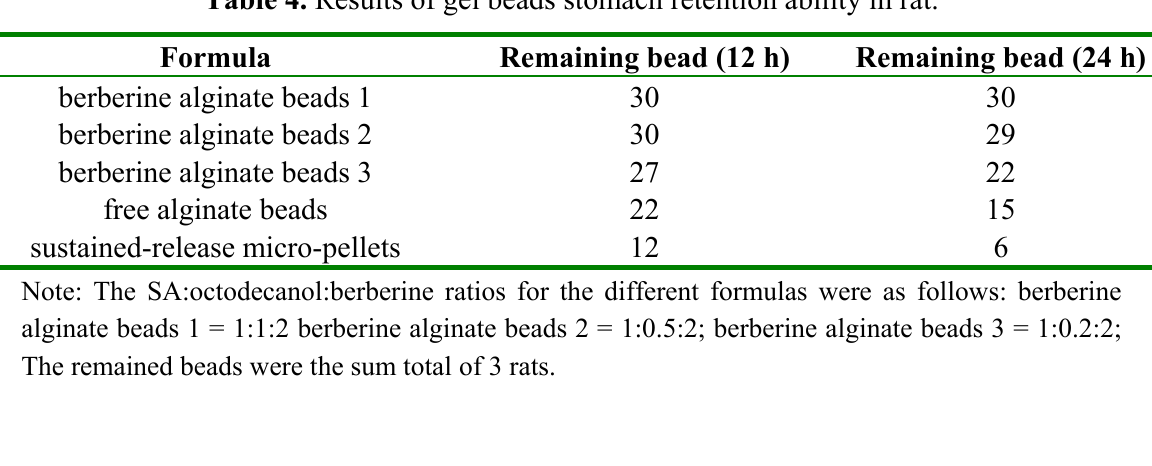
Table 4. Results of gel beads stomach retention ability in